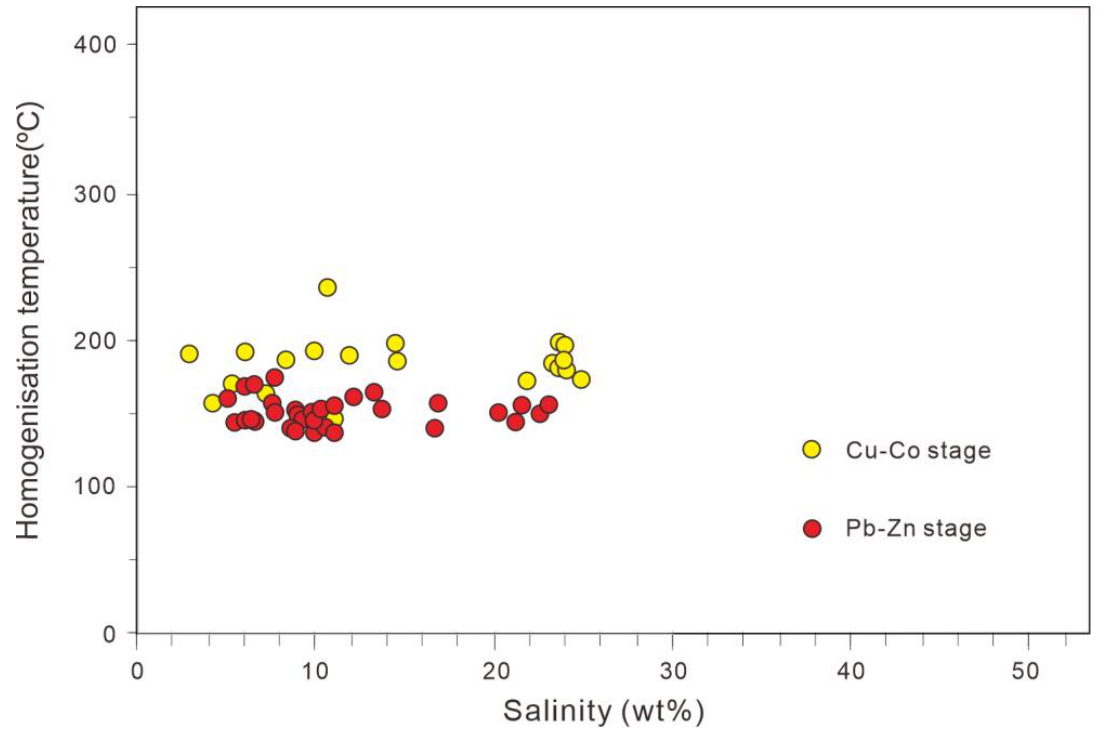
Figure 7. Summary plot of homogenization temperatures, salinities, and pressure of fluid inclusions related to the two stages at the BaiyangpingCu – Co – Pb – Zn deposit.